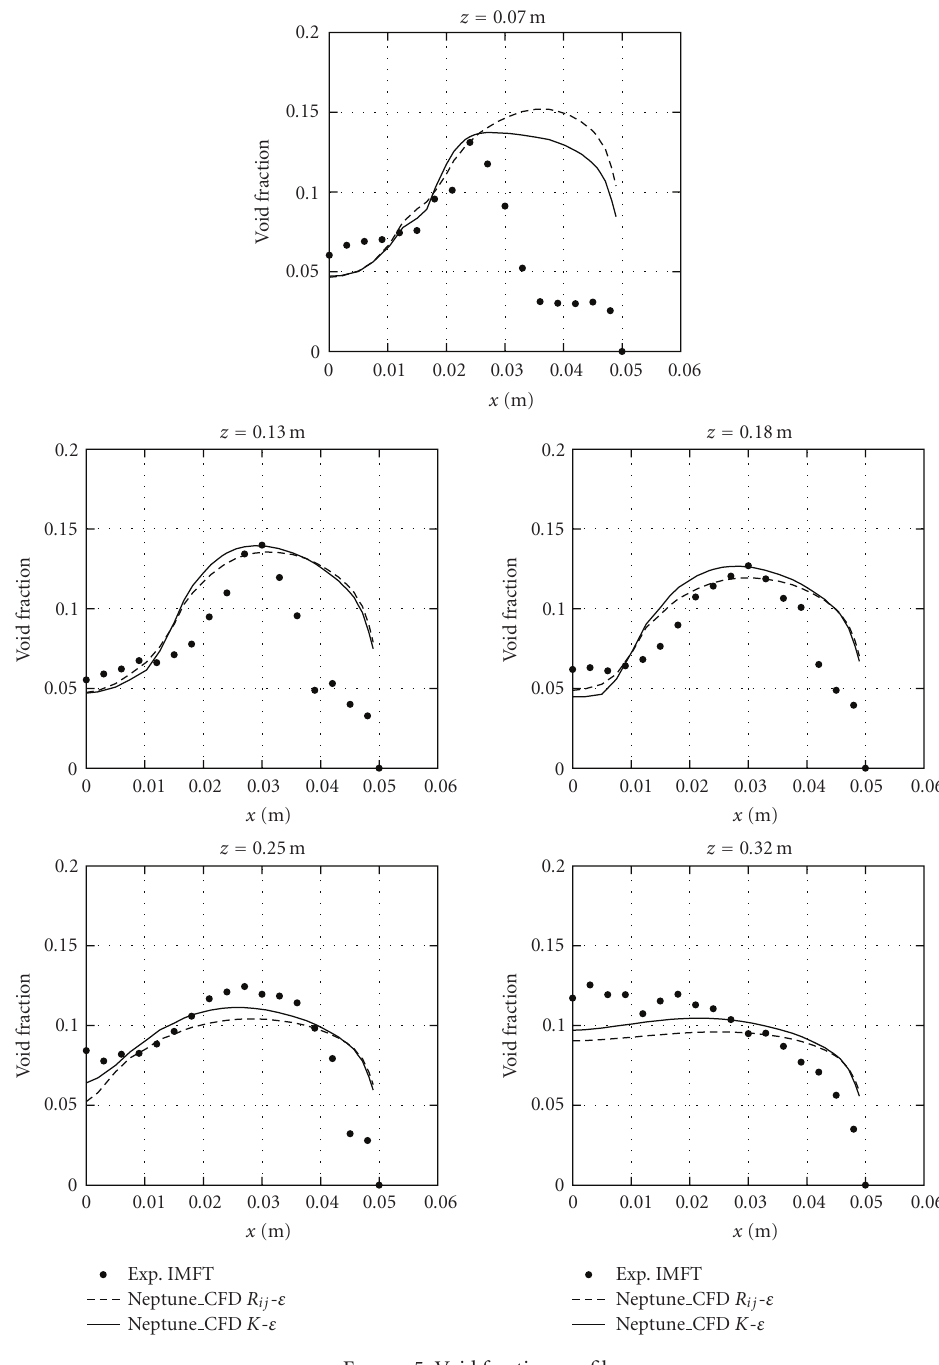
Figure 5: Void fraction